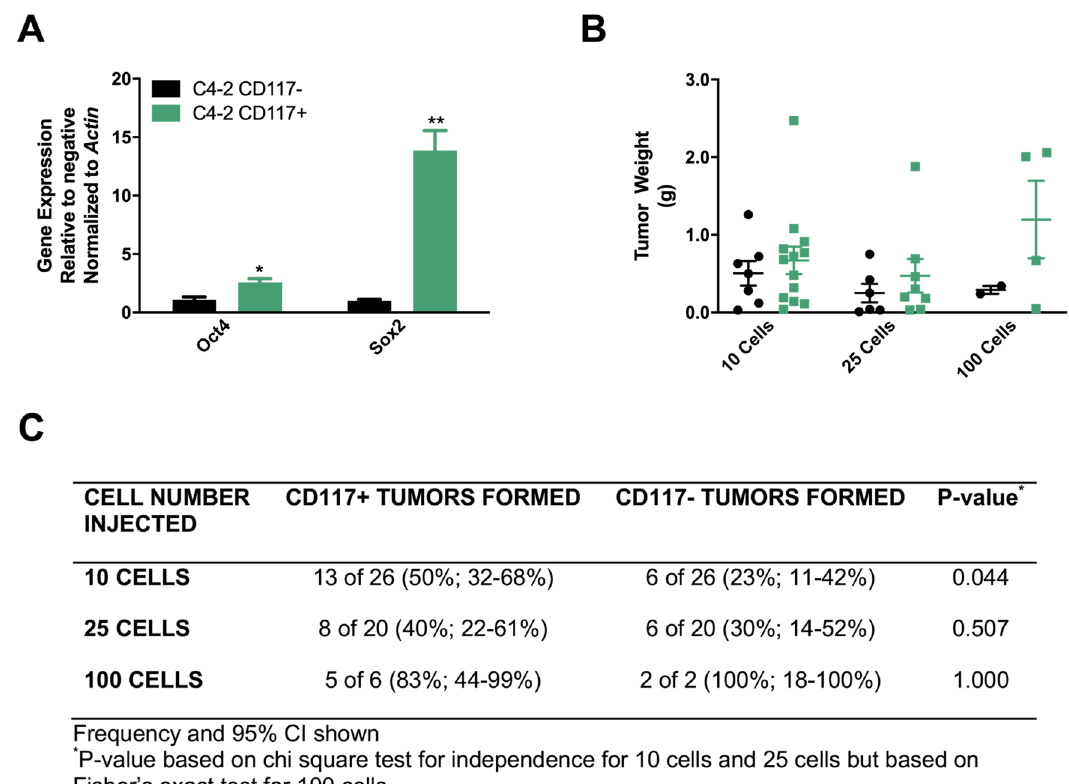
Figure 4. CD117+ cells represent a cancer stem-like cell. C4-2 cells were sorted into CD117+ and negative populations. ( A ) Gene expression of monolayer cultured cells was examined for the stemness markers Oct4 and Sox2 and represented as mean fold change ± SEM ( n = 4). ( B – C ) Sorted cells were injected into immunocompromised mice in a limiting dilution assay. Tumor weights ( B ) are represented as mean ± SEM ( n = 2–13). The number of tumors formed at each dilution is shown in ( C ) with the frequency percentage and 95% confidence intervals in parentheses. *Represents p < 0.05 and **represents p < 0.01 by Student’s t